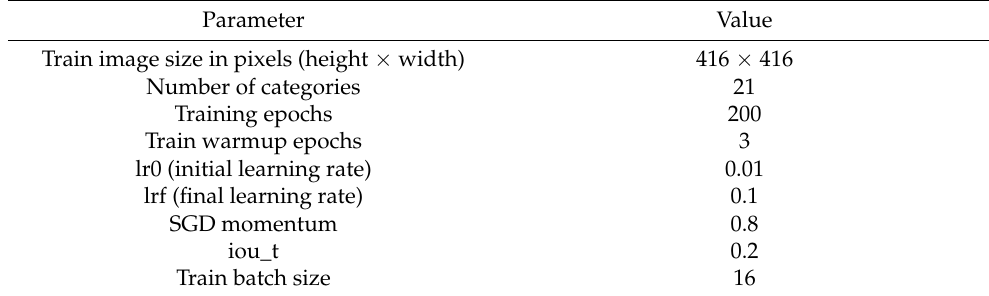
Table 2. Parameter settings for algorithm experiments.